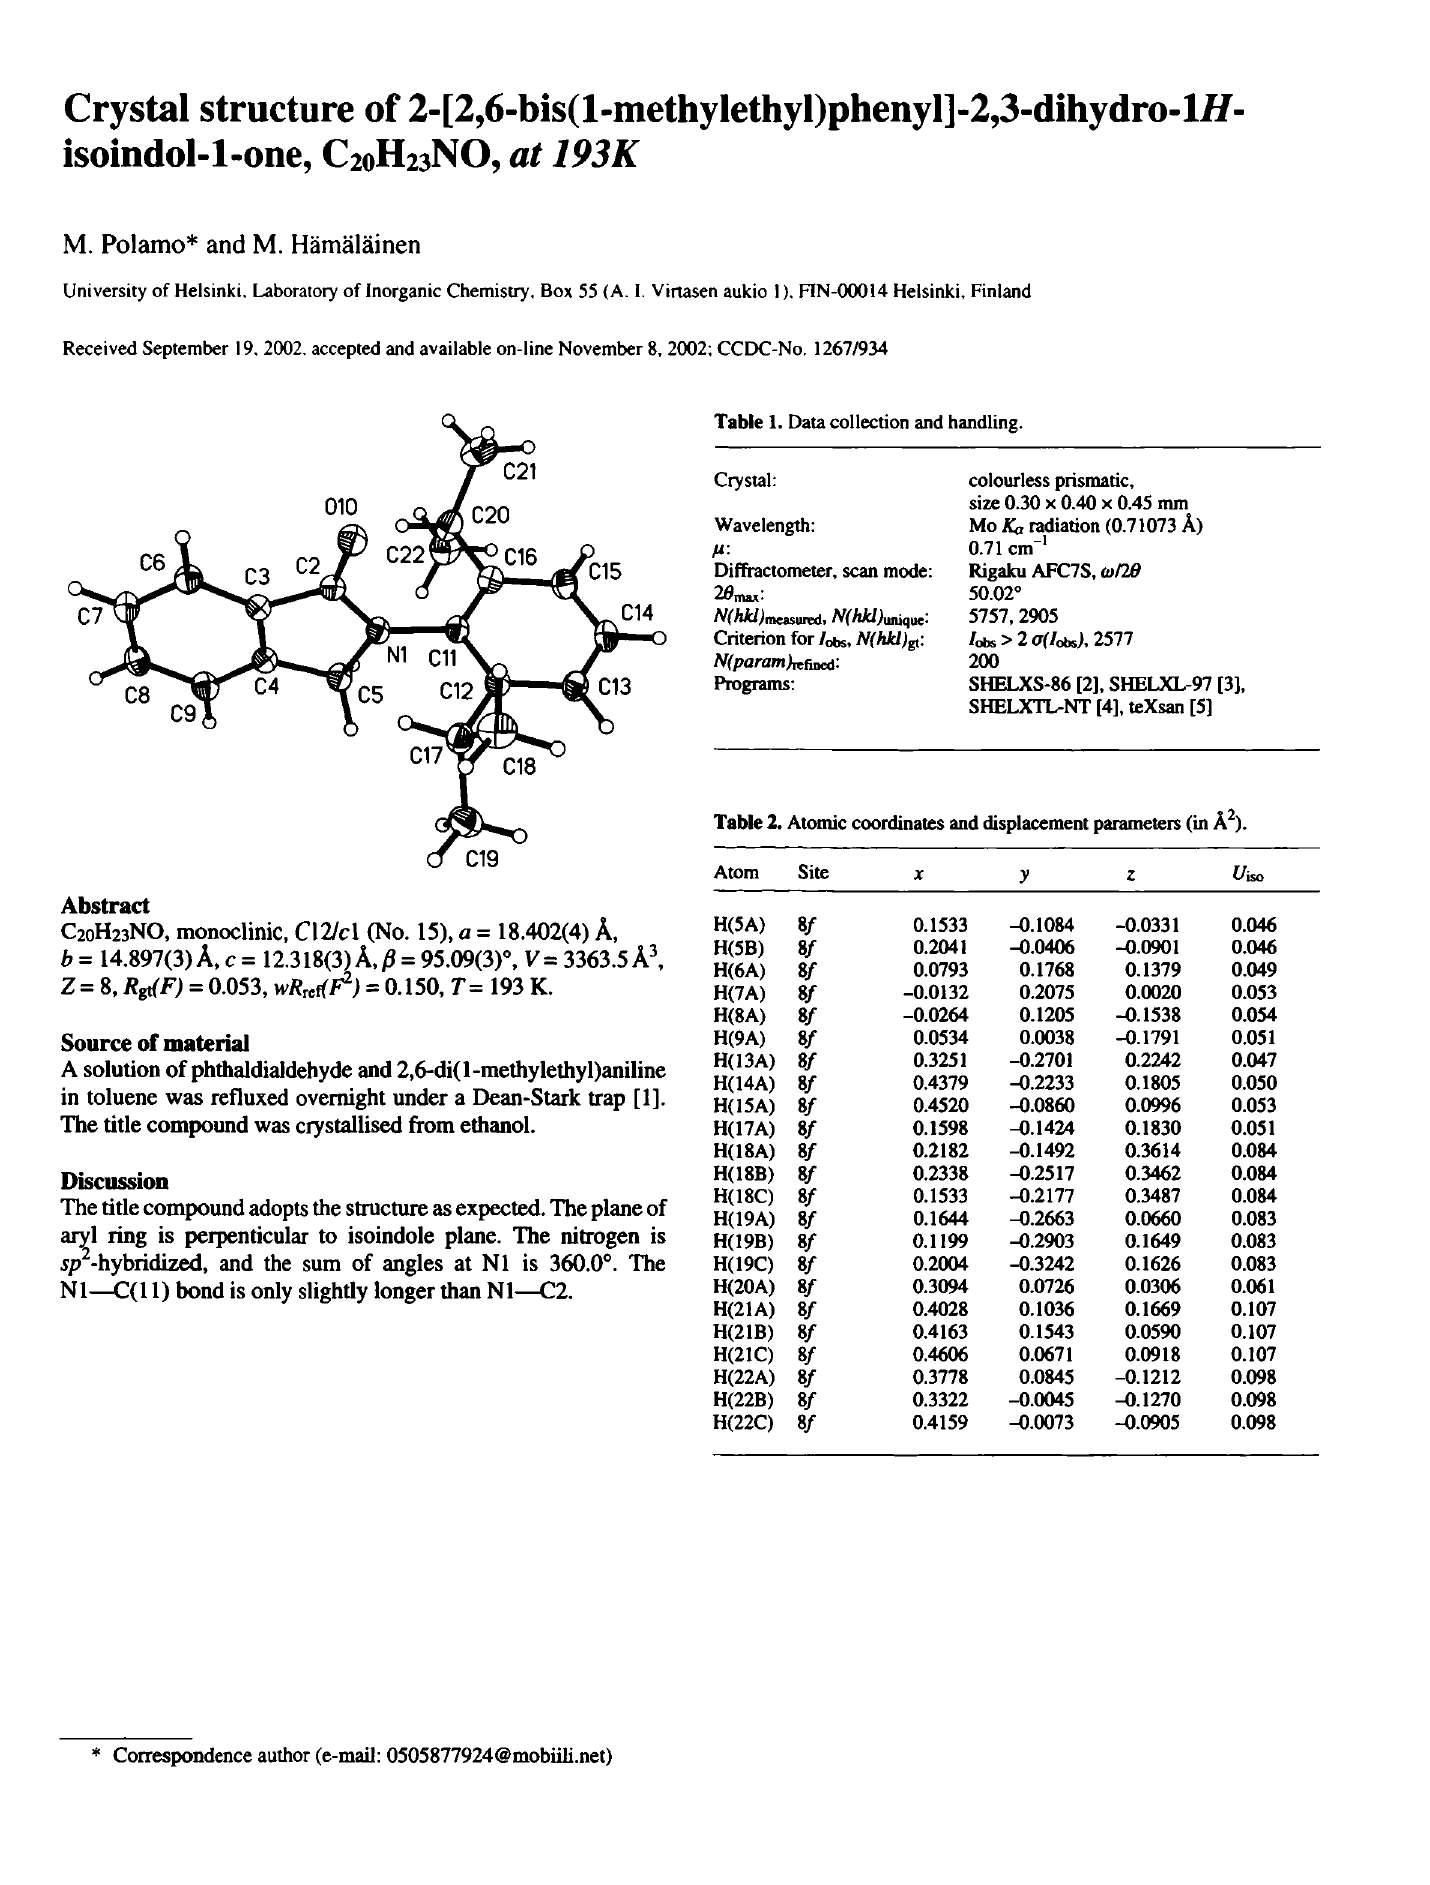
Table 1. Data collection and handling.